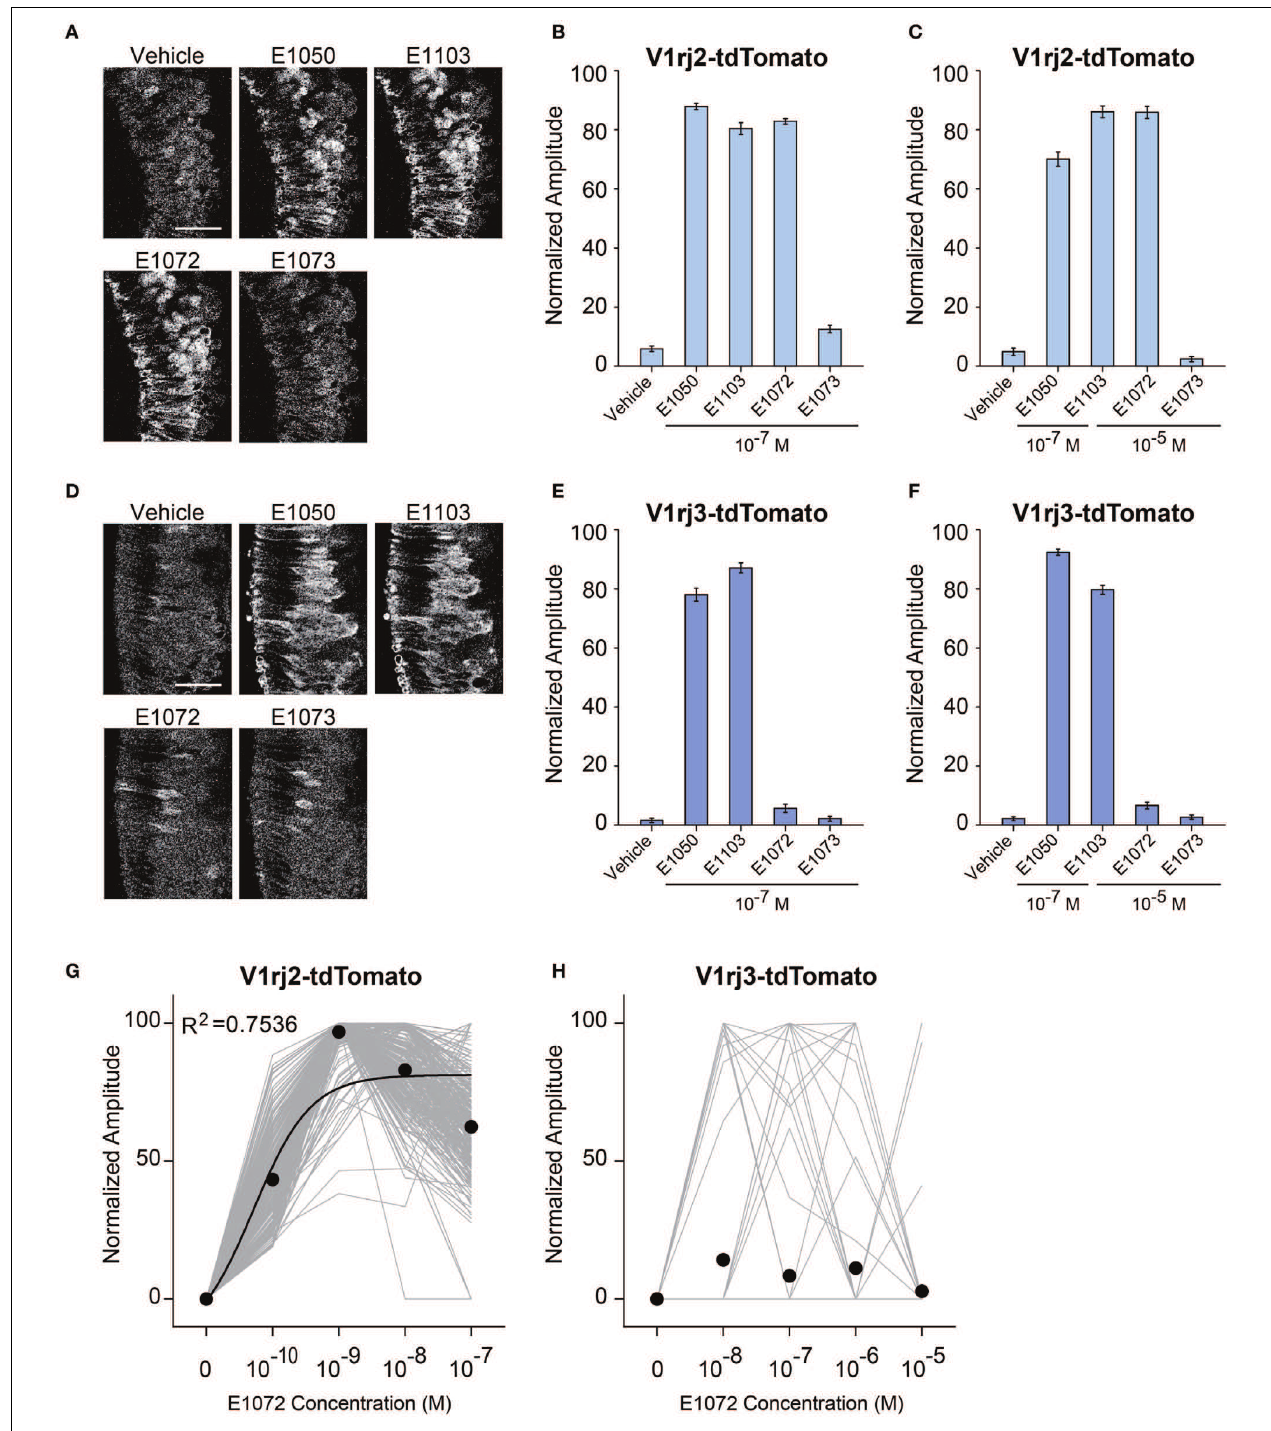
FIGURE 8 | Activation of V1rj2 and V1rj3 by Glucuronidated Estrogens. (A) Representative imaging experiments showing the responses of V1rj2 cells to vehicle control, E1050, E1103, E1072, and E1073 at 10 − 7 M. Scale bar, 50 µ m. (B) Bar graph showing the normalized response to E1050, E1103, E1072, and E1073 in V1rj2 cells at indicated concentration ( n = 409 ). (C) Bar graph showing the normalized response to E1050, E1103, E1072, and E1073 in V1rj2 cells at indicated concentrations ( n = 409 ). (D)